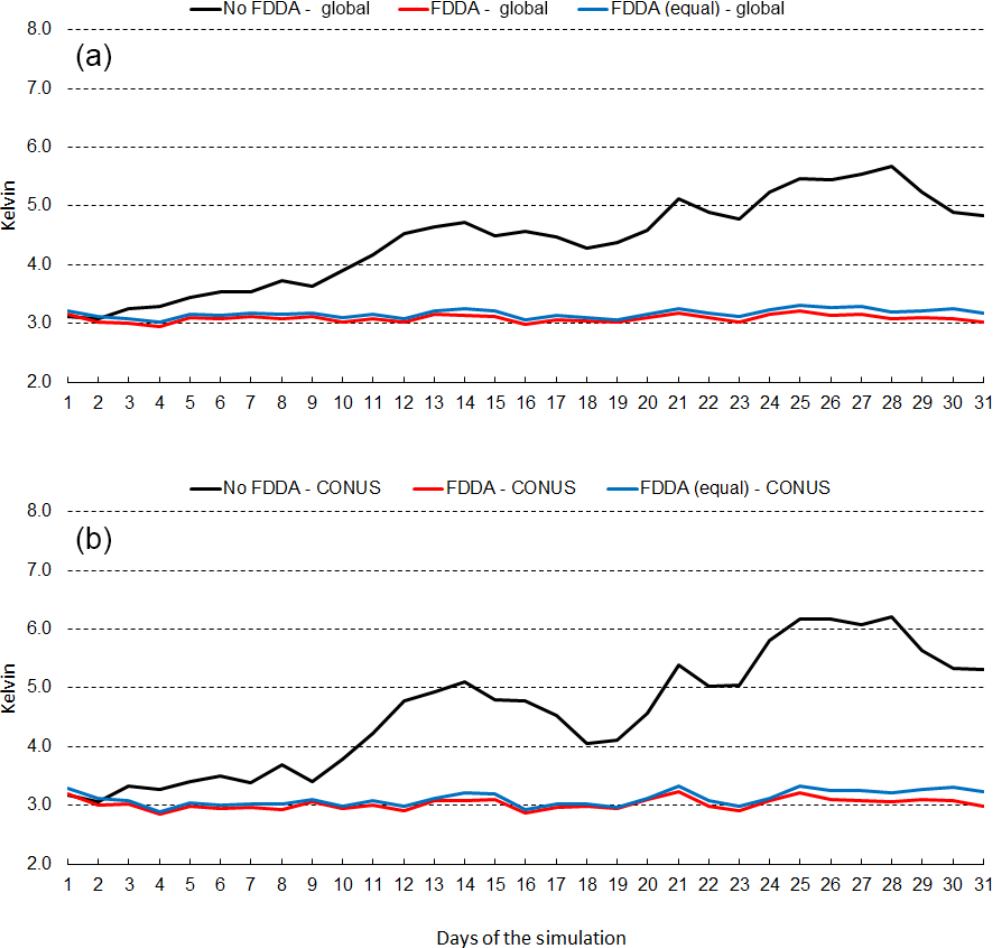
Figure 13. July 2013 time series plots of 2m temperature RMSE for MPAS-A without FDDA (black line), MPAS-A with FDDA applied using weaker q v nudging (red line), and MPAS-A with FDDA applied at equal strength for all variables (blue line). Panel (a) shows results for the entire global domain, while (b) shows results for the CONUS